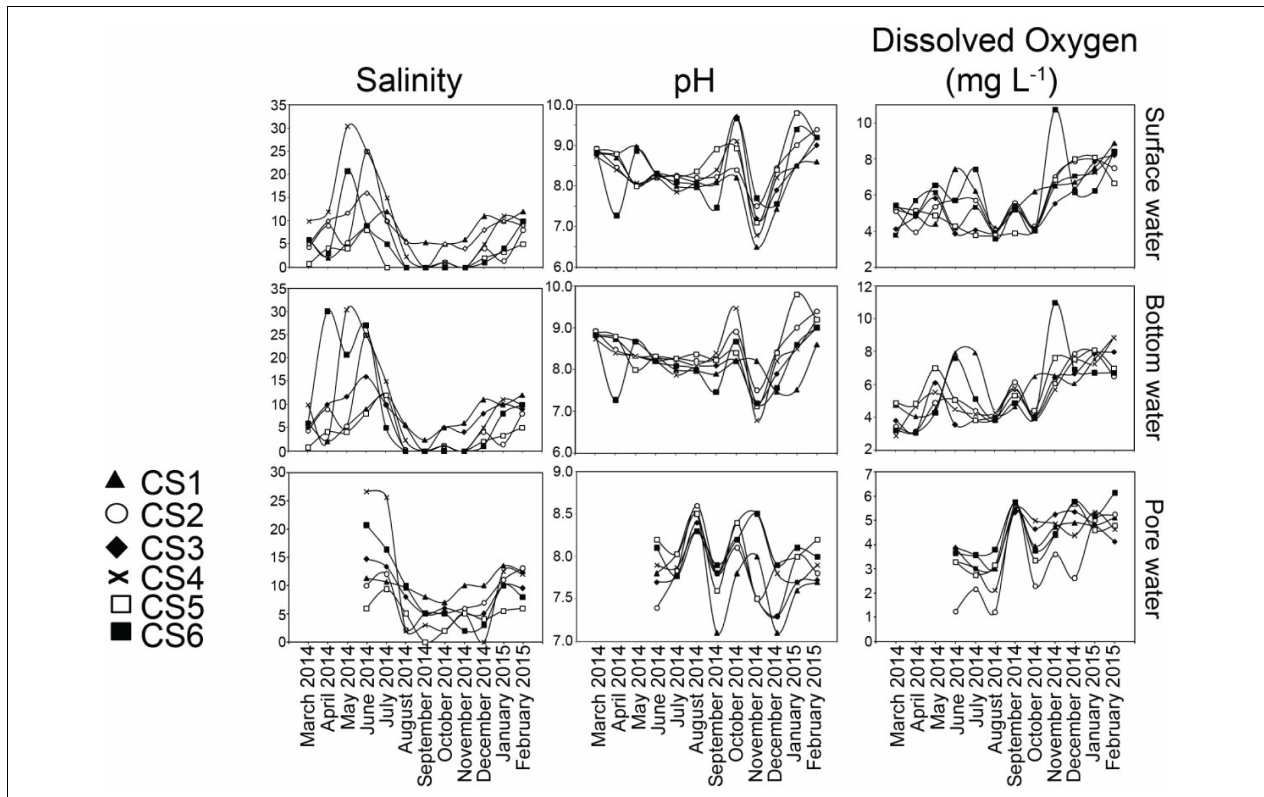
FIGURE 3 | Values of salinity, pH and dissolved oxygen measured for surface water, bottom water, and pore water (sediment) from each sampling station of the lagoon during the sampling period representing March 2014 to February 2015. For pore water, measurements of the above parameters were undertaken from June 2014 to February